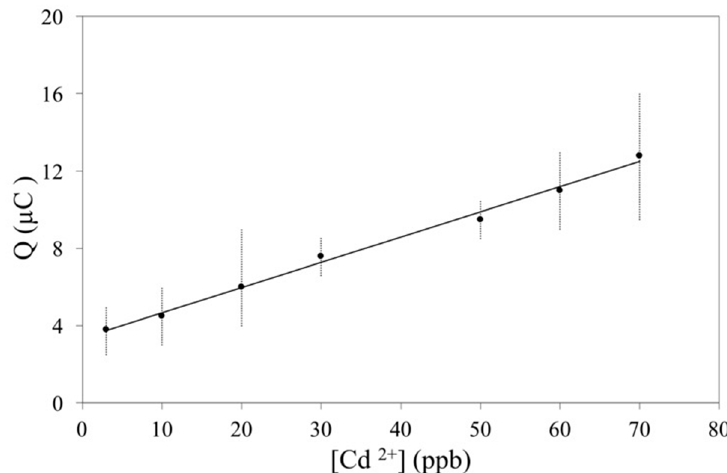
Figure 8. The calibration curve of Cd(II), at a concentration range of 2.67 × 10 − 8 and 6.23 × 10 − 7 M (i.e., 3 and 70 ppb) on the carbon paste electrode were modified with the PAA-co-IA / NaOH / B-MWCNT hydrogel in 0.1 M KNO 3 argon-saturated solutions at pH 5. Each point was obtained by DPV using the following conditions: The accumulation time was 2 min at open circuit potential under stirring, and the pre-concentrated Cd(II) was reduced to Cd(0) at − 0.95 V for 40 s, followed by anodic stripping (oxidation of Cd(0) to Cd(II)) from − 0.95 to 0.6 V with a 33.3 mV s − 1 scan rate, 40 mV pulses height, 75 ms pulses width, and 5 mV step height. Each point was measured eight times.